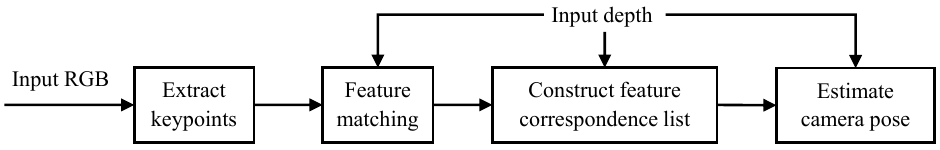
Fig. 2 Algorithm